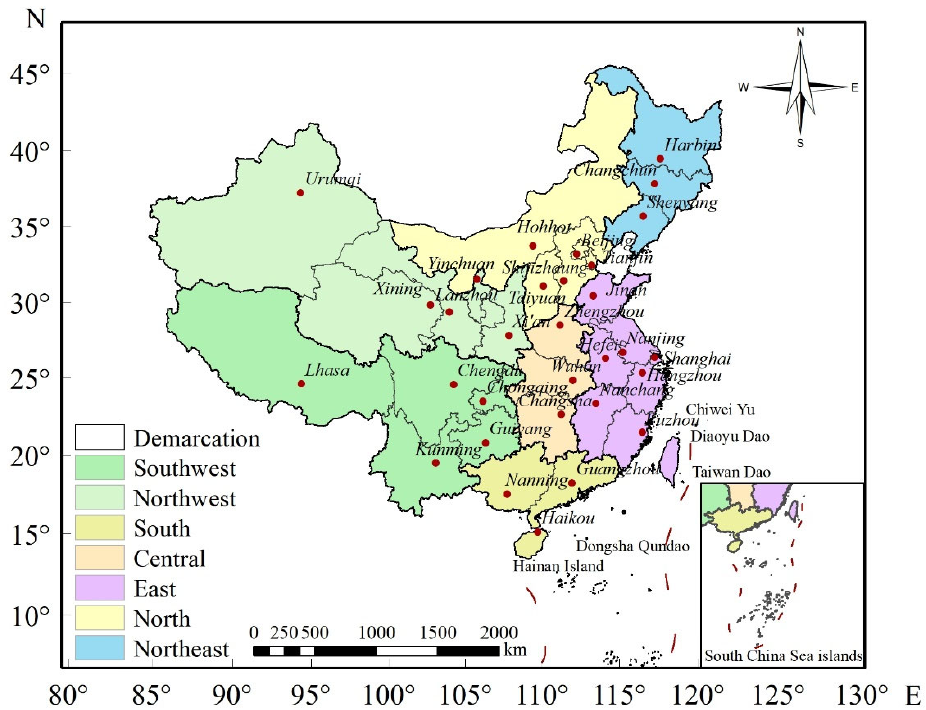
Figure 1. Map of China. (The seven geographical divisions in China are divided by the black color solid line).